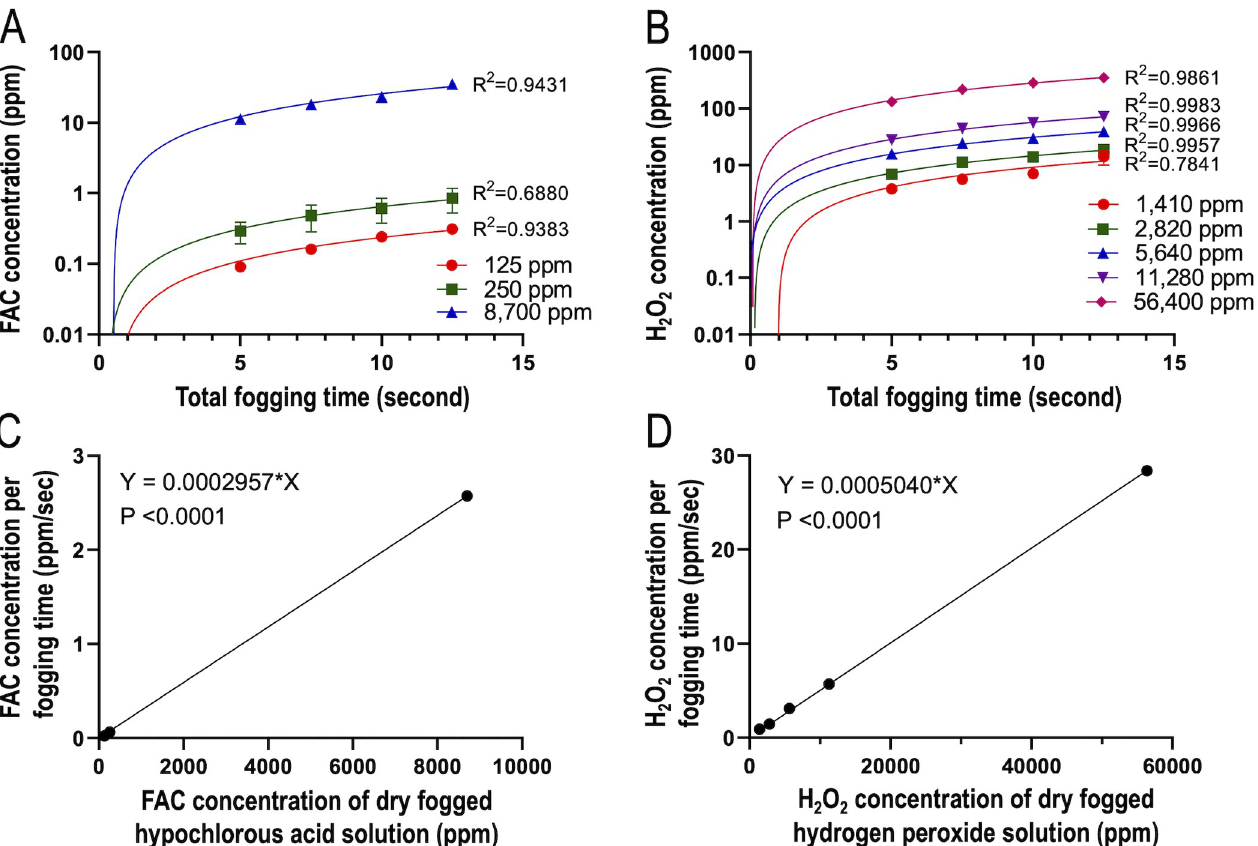
Fig 4. Relationship between dry fogged disinfectant concentrations and concentrations of disinfectants trapped in 20 ml of distilled water in Petri dishes. The dry fogging of hypochlorous acid solution (A) or hydrogen peroxide solution (B) was performed as described in the Materials and methods. The concentrations of free available chlorine FAC (C) and hydrogen peroxide (H 2 O 2 ) per unit fogging time (D) were calculated and plotted. R squared (R 2 ) values were estimated using a non-linear regression (curve fit) analysis and reported on the graphs (A and B). In addition, R 2 values, equations, and p values were estimated using a simple linear regression analysis and reported on the graphs (C and